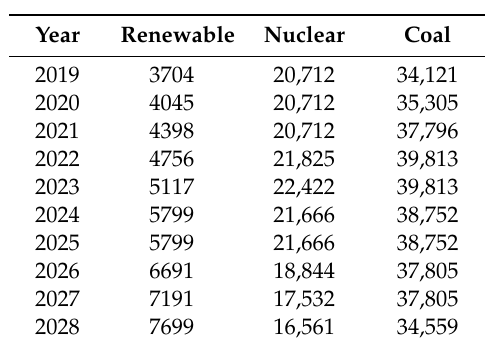
Table 3. Actual supply capacity of renewable, nuclear, and coal resources, 2019–2028 (Unit: